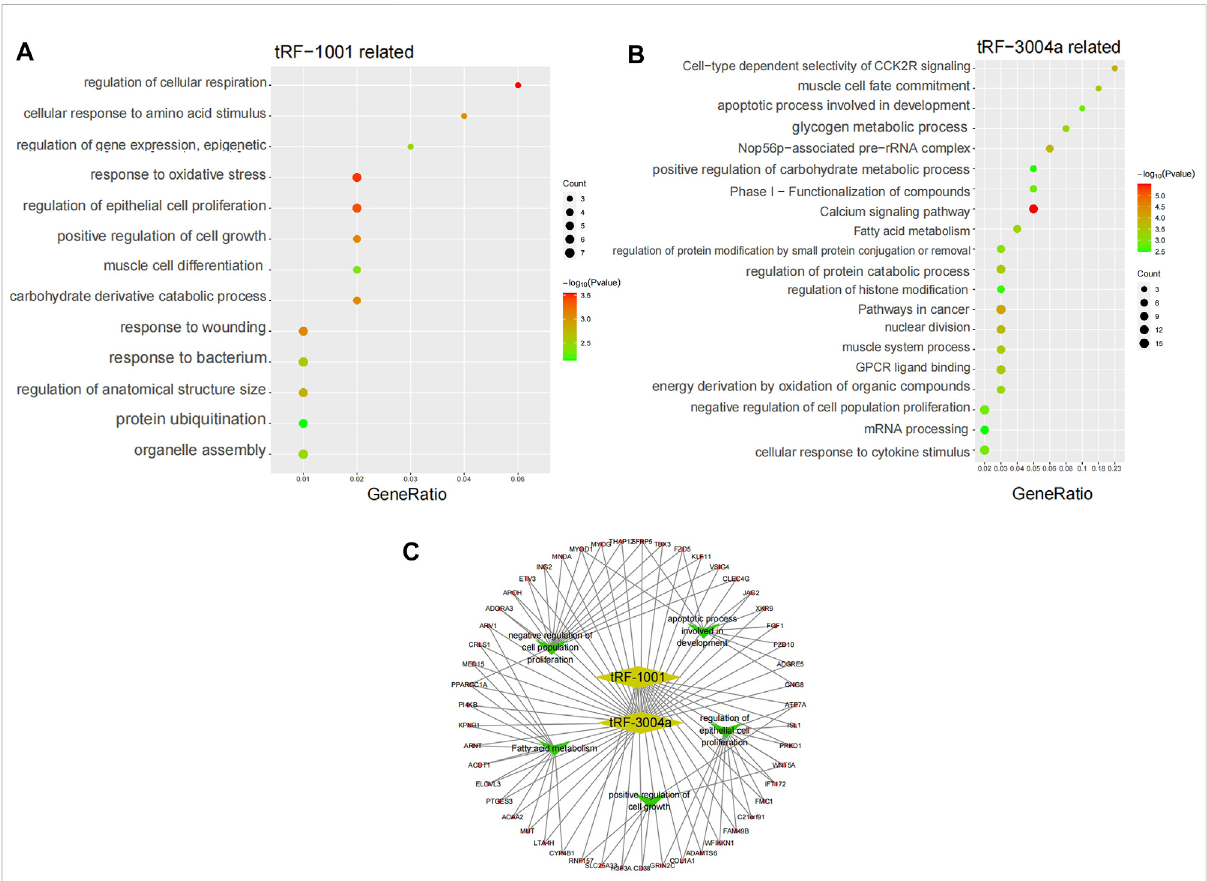
FIGURE 6 KEGG pathway analysis and pathways network. (A) KEGG pathway analysis of tRF-1001 target genes. The vertical axis shows the annotated functions of the target genes. The horizontal axis represents the enrichment score ( − log10 transformed p -value) and the gene number of each cluster, respectively. (B) KEGG pathway analysis of tRF-3004a target genes. (C) Network map of the core biological pathways and target genes of tRF-1001 and